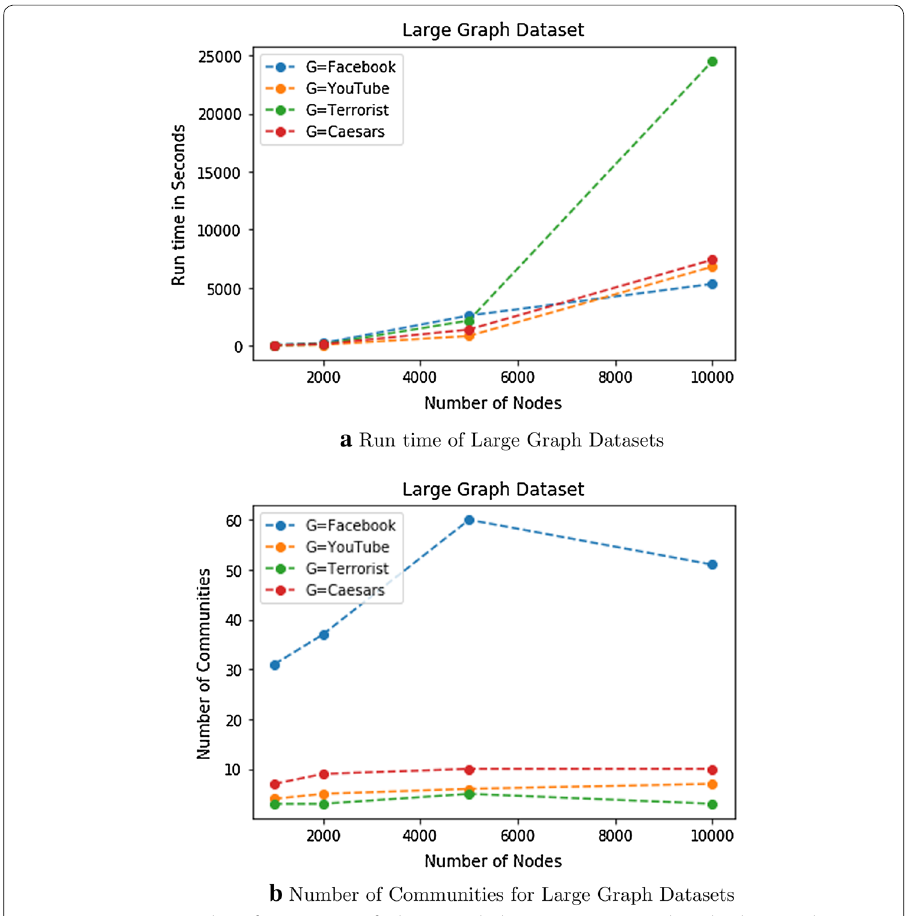
Fig. 8 Run time vs number of communities for large graph datasets. Experimental results showing the run time and the number of communities generated for large graph datasets using the proposed method